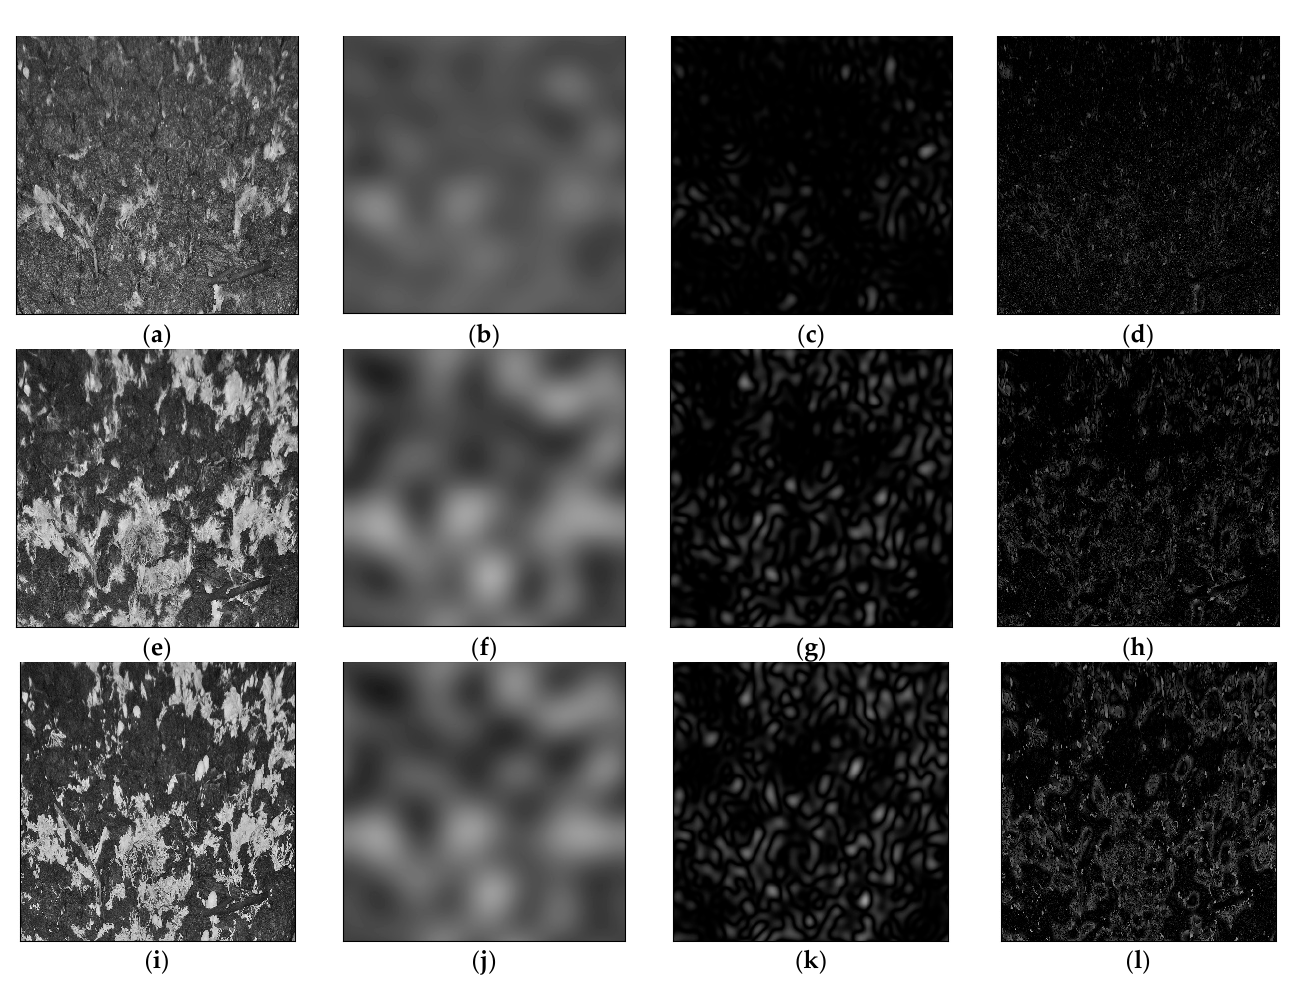
Figure 6. Grayscale images ( a , e , i ) and Fourier analysis results, that is, respective images of recon- structed based on low frequency ( b , f , j ), medium frequency ( c , g , k ) and high frequency filter ( d , h , l ) on the 5th, 9th, and 13th days of the mushroom production cycle.